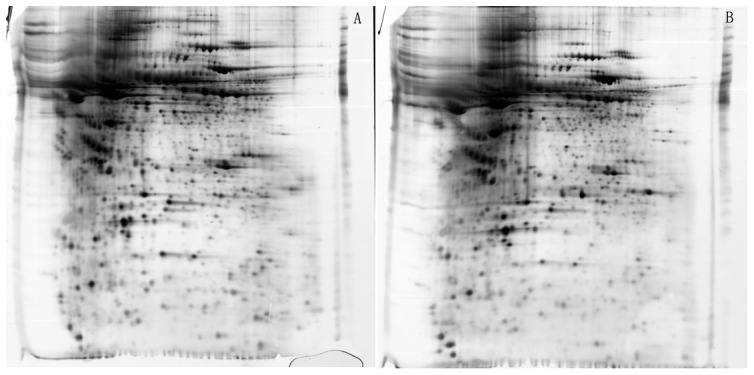
Analysis of plasma proteins before and after risperidone treatment using 2-DE.1st-dimension: separation of isoelectric focusing (IEF), immobilized pH gradient (IPG) strips PH3-10, non-linear. 2nd-dimension: SDS-polyacrylamide gels (SDS-PAGE), 18 cm 8–16% gradient gels. Proteins were visualized using silver staining. A: Before treatment. B: After treatment.